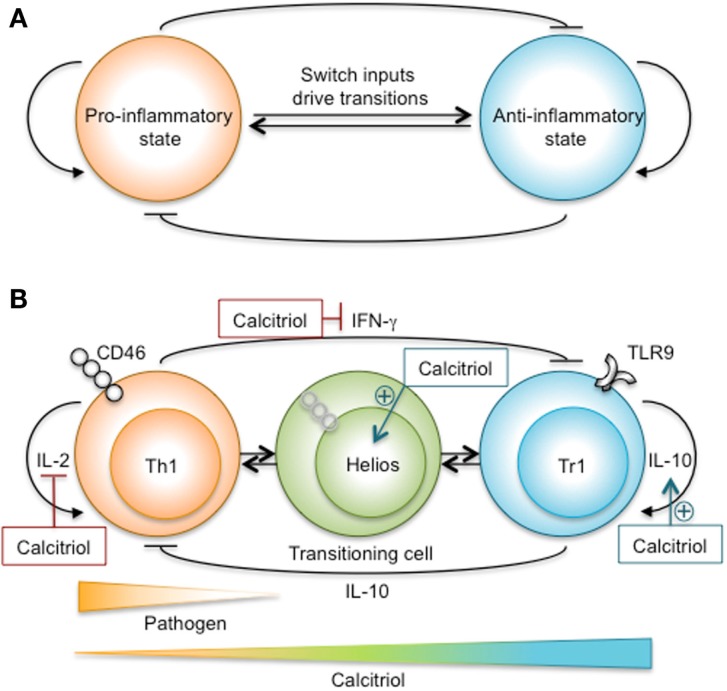
A proposed Th1–Tr1 bi-stable biological switch bridging two immune states, pro-inflammatory and anti-inflammatory. (A) A theoretical diagram of two opposing immune states [adapted from a generalized bi-stable switch diagram (302)]. Each circle represents T cells that are in a stable biological state characterized by a particular gene regulatory network and capable of responding to external stimuli in a biologically appropriate manner. Biological barriers impede transitions between the pro- and anti-inflammatorystates. Each biological state is capable of reinforcing its own state, denoted as lines terminating in arrows, and inhibiting the opposing state, denoted as blocked lines. External stimuli, for example pathogens, hormones, cell-cell interactions, and soluble mediators serve as switch inputs to drive a transition. For example, signals 1 and 2 can be organized as “1 or 2”, “1 and 2”, or “1 not 2” to trigger a dynamic transition between the two states. (B) The proposed Th1–Tr1 switch appears to have the qualities of a bi-stable biological switch. The Th1 cytokine IFN-γ and the Tr1 cytokine IL-10 impede the development of Tr1 and Th1 cells, respectively. The autocrine growth factors IL-2 and IL-10 reinforce the survival and proliferation of Th1 and Tr1 cells, respectively. Diminishing pathogen, sensed through TLR molecule engagement (280), maturation of the pathogen-specific immune response, sensed through CD46 molecule engagement by C3b and C4b (299, 300), and accumulating calcitriol in the microenvironment, sensed through the VDR in Th1 cells, provide the external stimuli to alter the dynamics of the system and drive the transition to the Tr1 biological state. Helios may be a biomarker of effector T cells undergoing a transition to a tolerant state (183). Calcitriol increased Helios in CD4+ T cells at the beginning of a calcitriol-induced EAE disease remission (144), and was recently identified as an inhibitor of Il2 gene transcription by an epigenetic silencing mechanism (184).